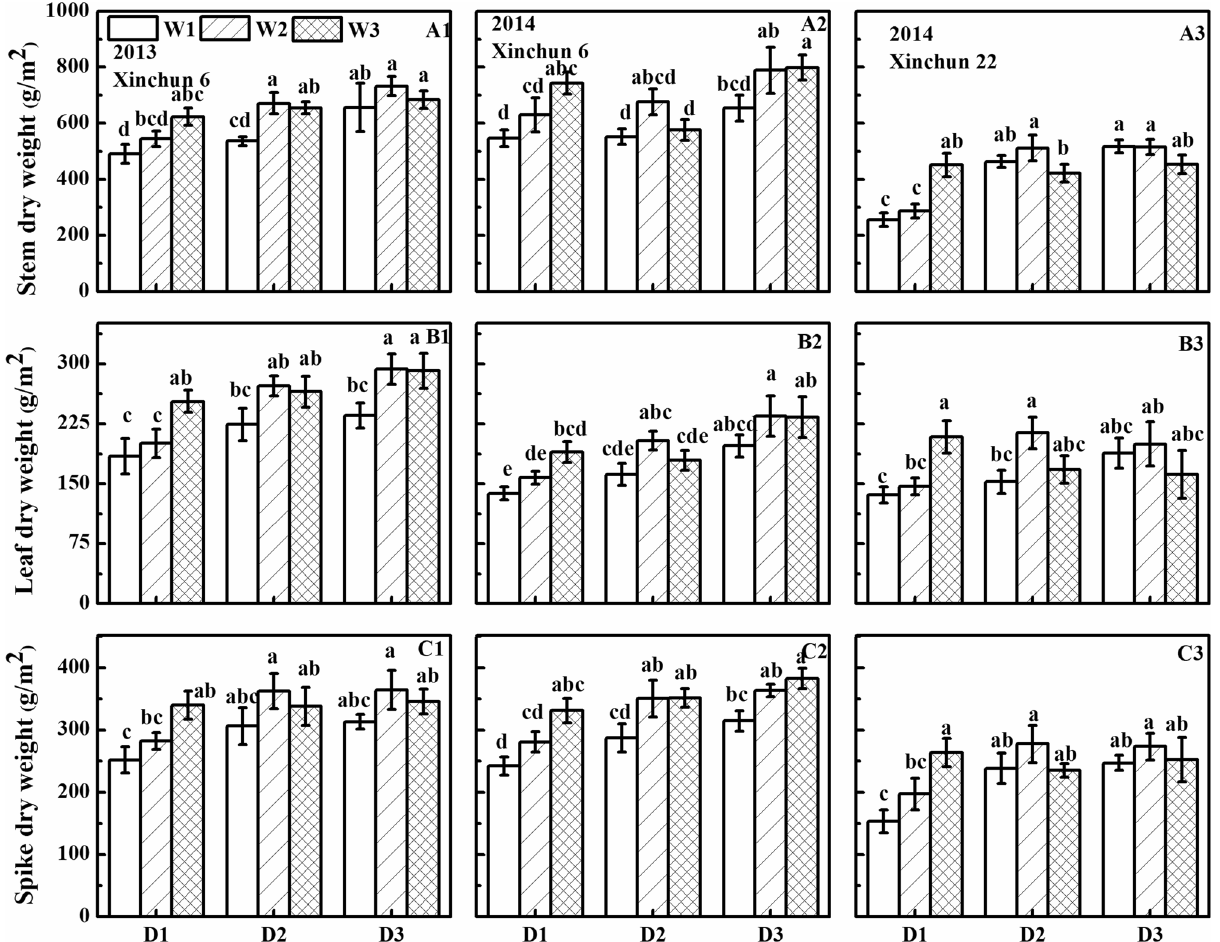
Figure 6. Dry weight of different wheat organs at flowering as affected by irrigation frequency and amount. ( A1 ) The stem dry matter of ‘Xinchun 6’ in 2013. ( B1 ) The leaf dry matter of ‘Xinchun 6’ in 2013. ( C1 ) The